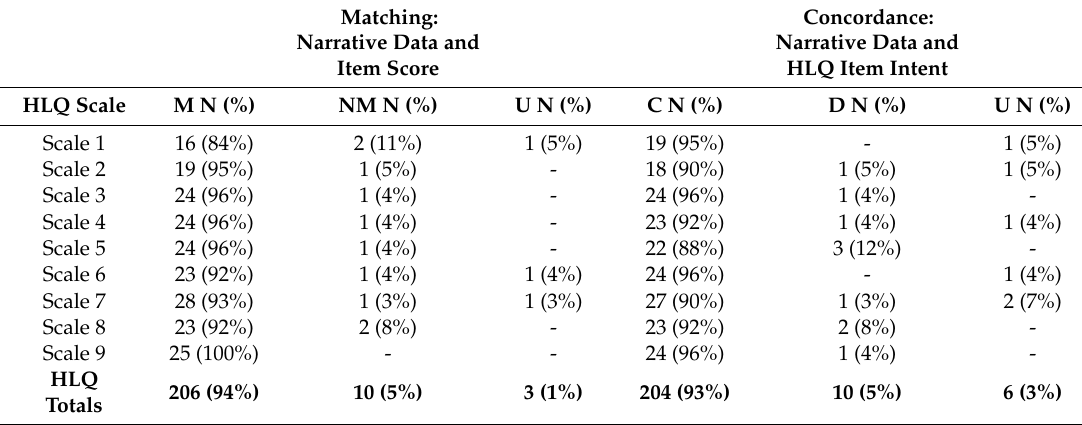
Concordance: Narrative Data